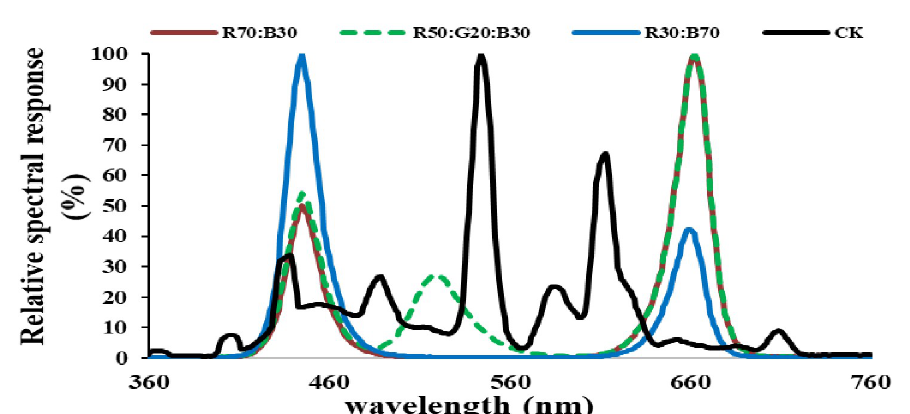
Fig 1. Relative spectral response of the light modes and control in the